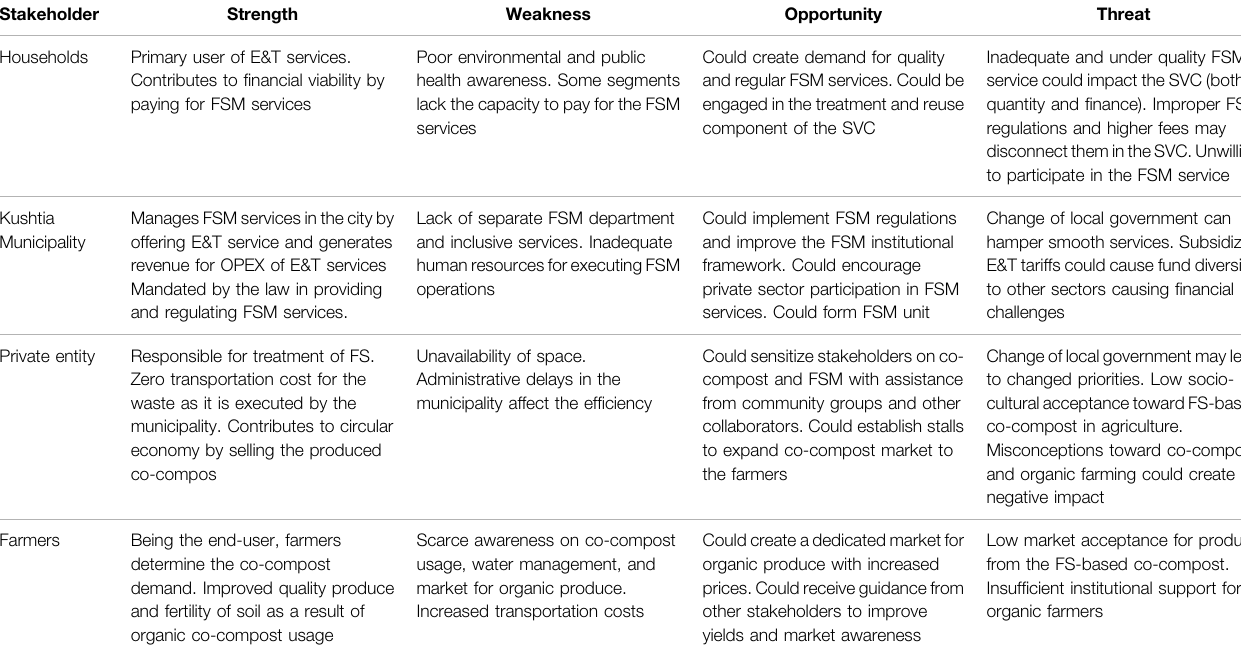
TABLE 6 | SWOT analysis of FSM stakeholders. Stakeholder Strength Weakness